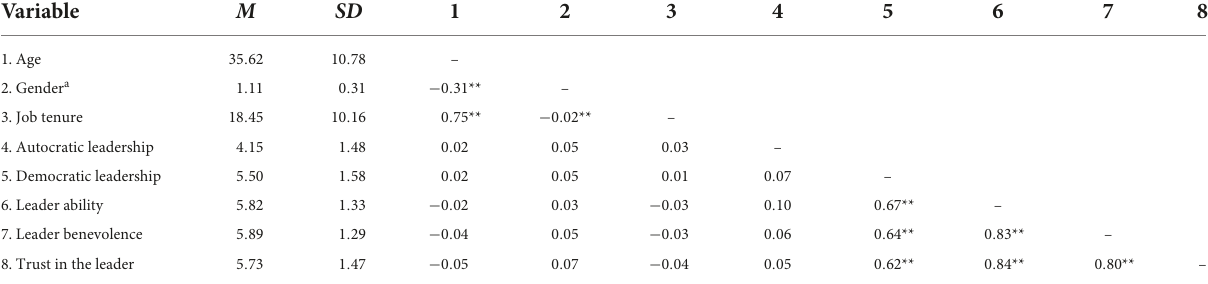
TABLE 5 Descriptive statistics and correlations for the transition phase (Study 2).